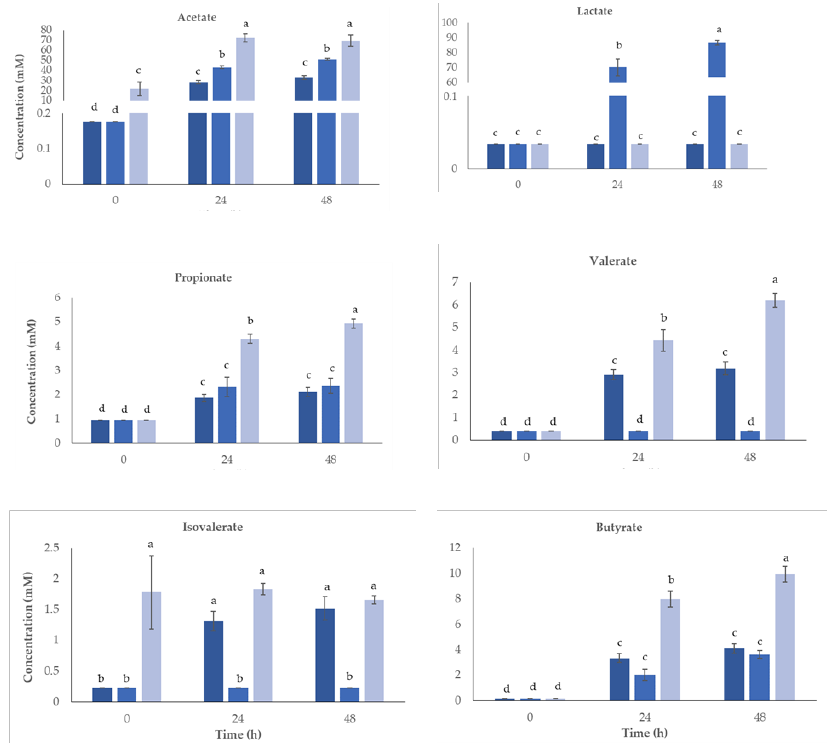
Figure 5. Concentration (mM) of the short-chain fatty acids (SCFA) and lactate produced for 48 h of human colonic fermentation using straw extract obtained after fermentation with S. cerevisiae . Inoculum control (IC, (cid:4) ), fructo-oligosaccharides (FOS, (cid:4) ), and straw extract after fermentation with S. cerevisiae ( (cid:4) ). a,b,c,d Significant variations ( p < 0.05) between samples for each acid are denoted by different